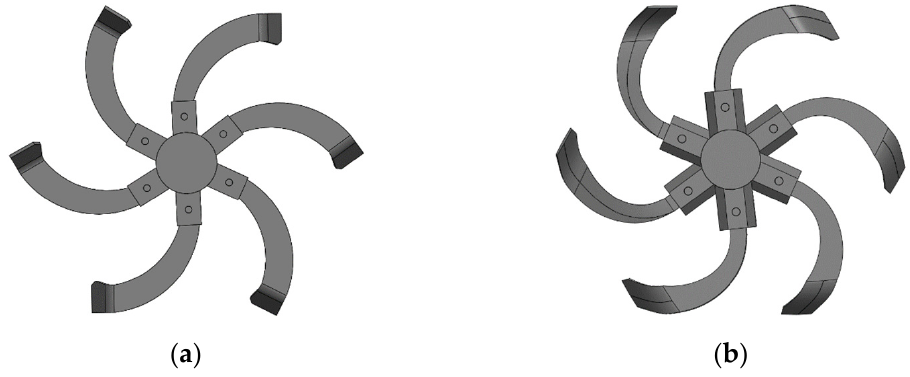
Figure 6. Simulation model of up-cut rotary blade. ( a ) IT245 rotary blade; ( b ) IT245P rotary blade.